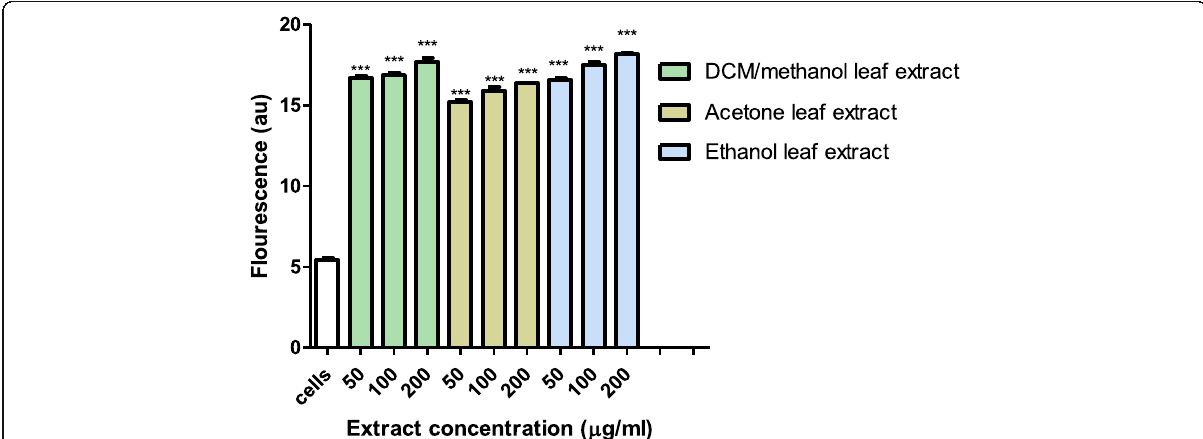
Fig. 4 Fluorescence of propidium iodide bound to nucleic acids of P. aeruginosa cells after exposure to the acetone, ethanol and DCM/methanol leaf extracts from Triumfetta welwitschii . Cells with no extract were used as the control. Values are for mean ± standard deviation (error bar) for n = 3. The asterisks indicate a significant difference from the control with *** p <